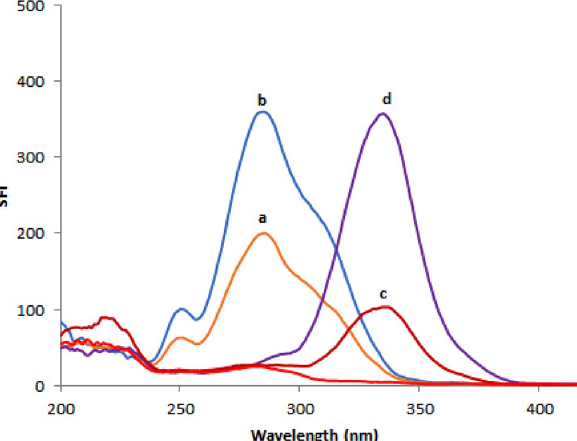
Figure 3. Synchronous fluorescence spectra indicating resolved peaks of the studied drugs. Where: (a, b): 0.2 and 0.4 μg/mL REM, (c, d): 0.1 and 0.4 μg/mL SIM in ethanol (blank